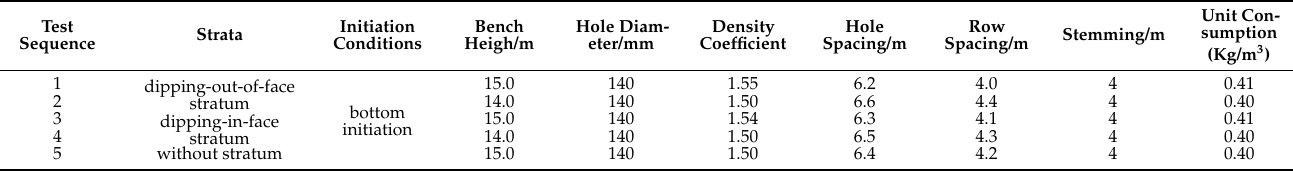
Table 2. Blasting parameters of the field